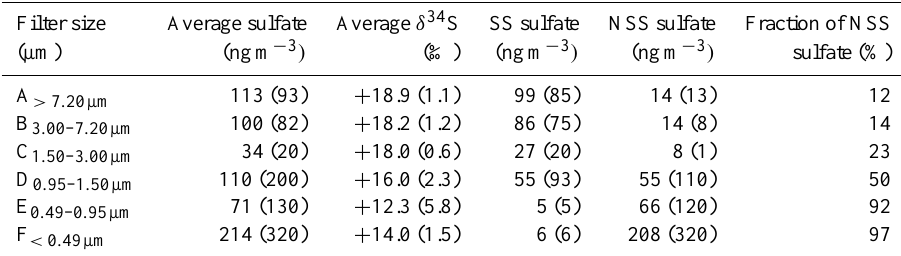
Table 2. Average TOTAL, sea salt and non-sea-salt sulfate concentrations (ngm − 3 ) , sulfur isotopic values (‰), and non-sea-salt fraction (%) for size-segregated aerosol filters. Standard deviations are reported in parentheses. Filter